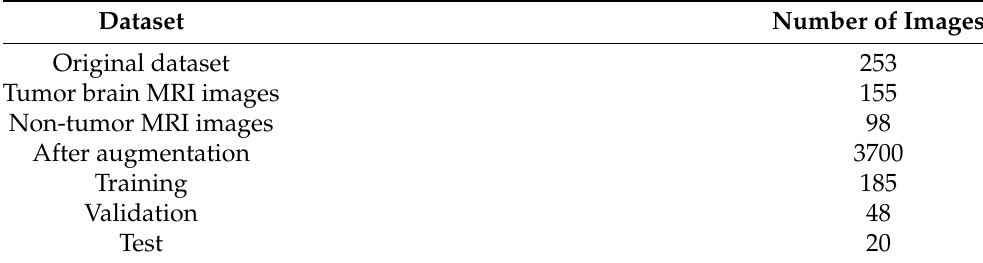
Table 3. Dataset before and after